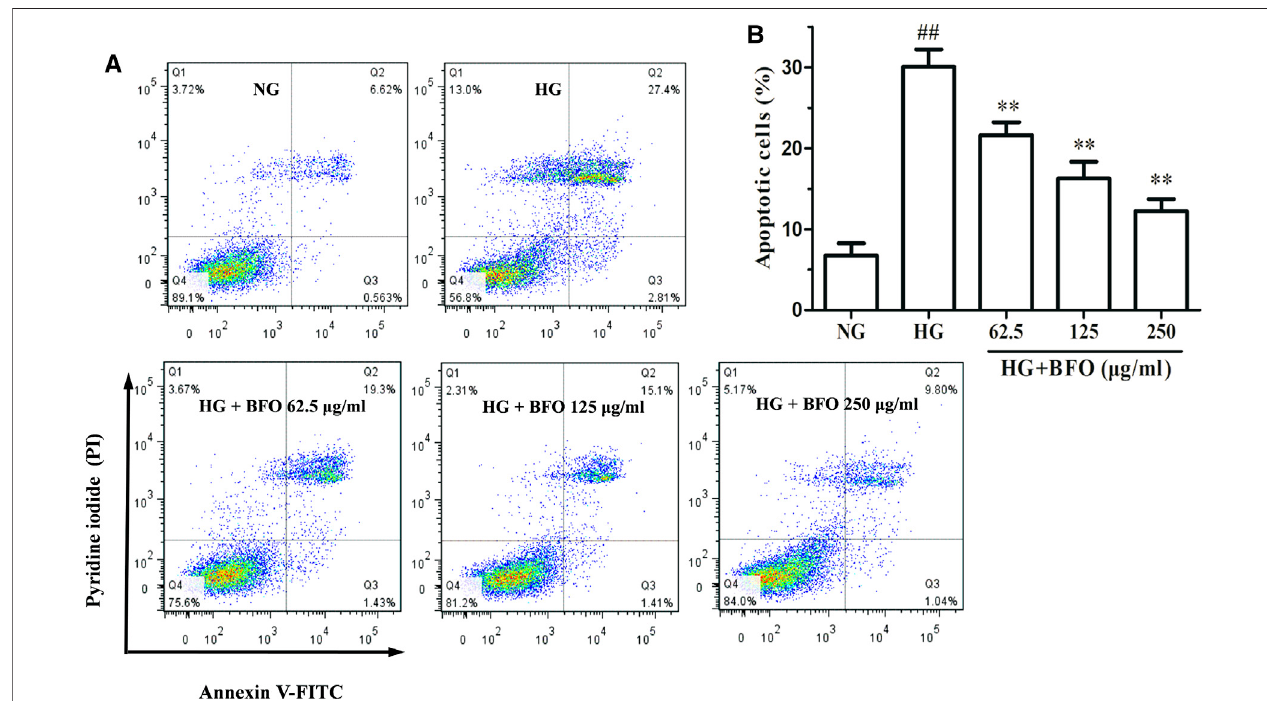
FIGURE 3 | Effect of BFO on apoptosis in NRK-52E cells. Apoptosis of NRK-52E cells cultured with high glucose (HG) and different concentrations of BFO was measuredbyAnnexinV-FITC/PIstaining. (A) RepresentativeimagesofapoptoticNRK-52Ecellsdetermined via fl owcytometry. (B) Quanti fi cationofapoptoticNRK-52E cells. All data are expressed as the mean ± SD. ## p < 0.01 vs. normal glucose (NG), ** p < 0.01 vs. HG.